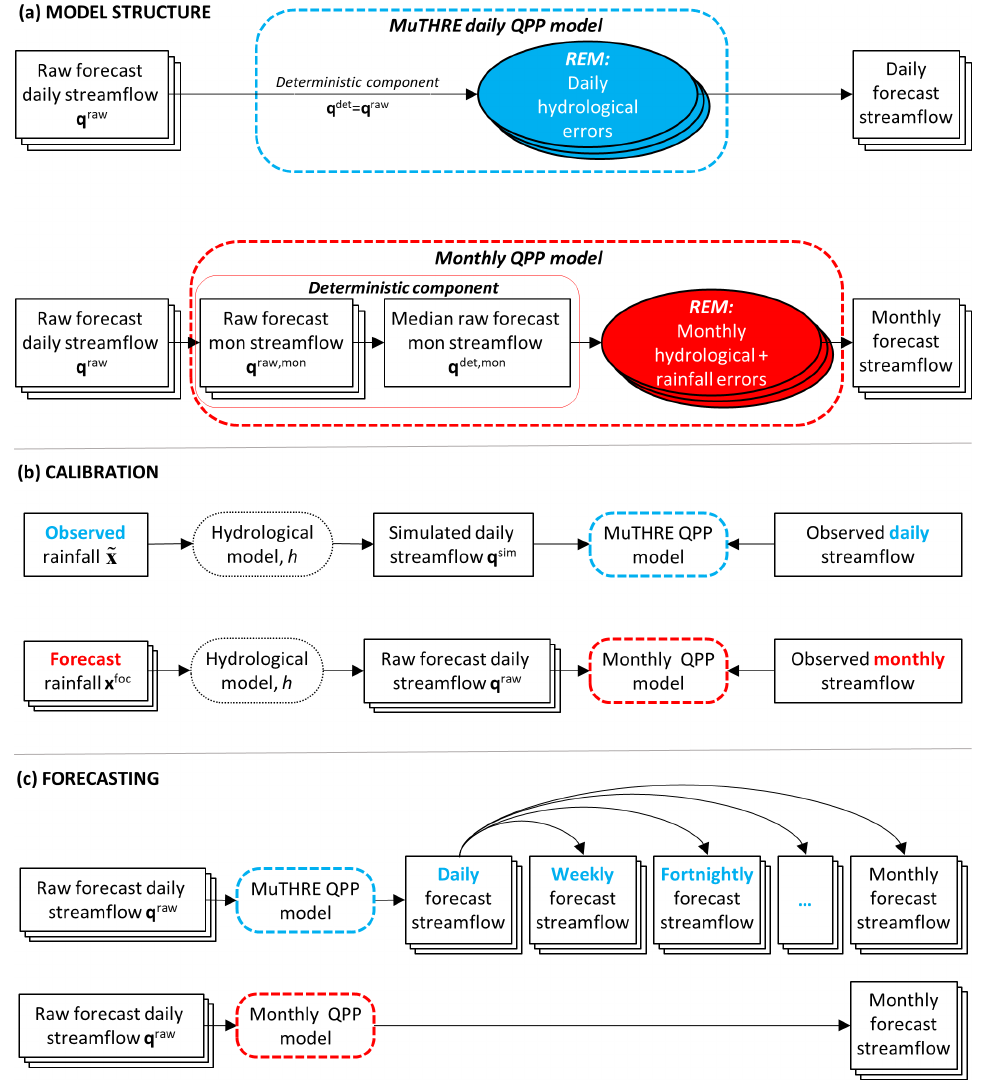
Figure 2. Conceptual diagrams of the seamless MuTHRE model and the non-seamless monthly QPP model. Ensemble components are indicated with multiple layers. Panel (a) shows the post-processing model structure, including the deterministic component and the residual error model (REM). Panel (b) shows the calibration approach to estimate the parameters of the streamflow post-processing model. Panel (c) illustrates the key distinction between the forecasting products generated by the models, where the MuTHRE model produces seamless daily streamflow forecasts that can be used at a range of lead times and aggregation periods (e.g. daily, weekly, fortnightly, and monthly), whereas the monthly QPP model produces only monthly